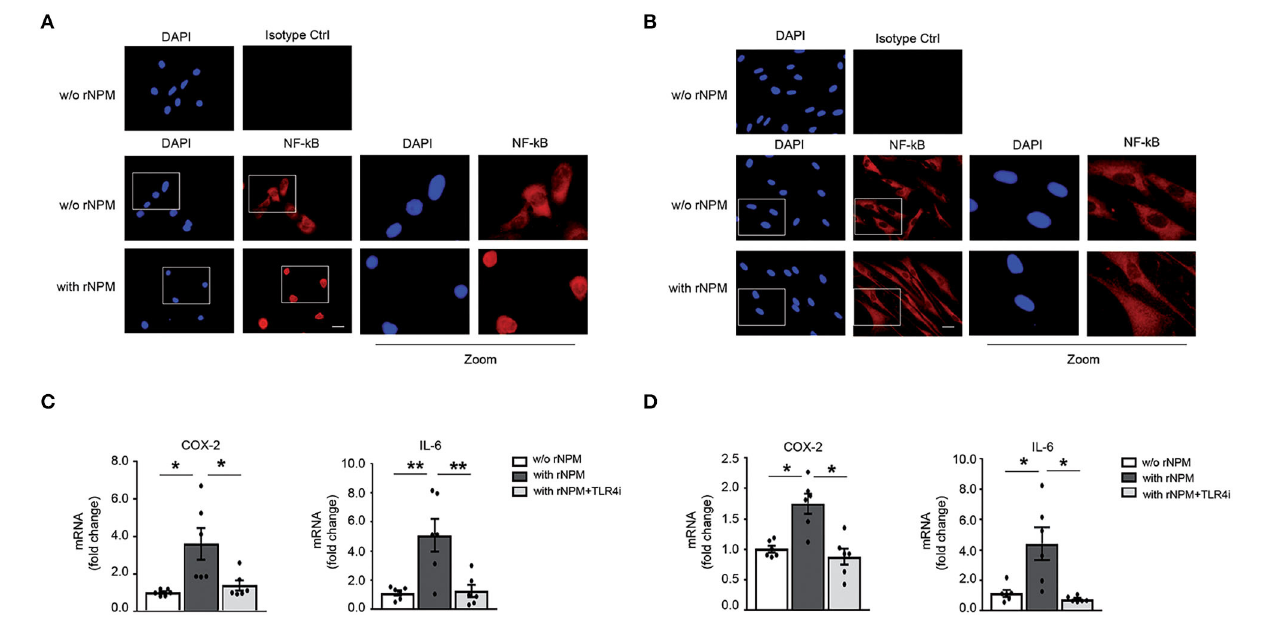
FIGURE 5 | rNPM promotes NF- κ B translocation to the nucleus and induces inflammation in HaCaT and HFs via TLR4. (A) Representative image of immunofluorescence of NF-kB (red) with an α -p65rel NF-kB antibody, nuclei were counter-stained with DAPI (blue). NF κ B translocated in the nucleus in HaCaT treated for 8h with rNPM (0.25 µ g/ml) compared to untreated cells (w/o NPM). Mouse IgG isotype control was used as a negative control. Left panels represent zoomed-in images of the original images. Scale bar 5 µ m. (B) Representative image of immunofluorescence of NF-kB (red) with an α -p65rel NF-kB antibody, nuclei were counter-stained with DAPI (blue). NF- κ B translocated in the nucleus in HFs treated for 8h with rNPM (0.25 µ g/ml) compared to untreated cells (w/o NPM). Mouse IgG isotype control was used as a negative control. Left panels represent zoomed-in images of the original images. Scale bar 5 µ m. (C) HaCaT were pre-treated with 100 µ M TLR4i for 30min and then treated or not for 8h with rNPM (0.25 µ g/ml) compared to untreated cells (w/o NPM). qRT-PCR of COX-2 and IL-6 was significantly reduced by TLR4i upon rNPM treatment ( n = 6; * p < 0.05; ** p < 0.01). (D) HFs were pre-treated with 100 µ M TLR4i for 30min and then treated or not for 8h with rNPM (0.25 µ g/ml) compared to untreated cells (w/o NPM). qRT-PCR of COX-2 and IL-6 was significantly reduced by TLR4i upon rNPM treatment ( n = 6; * p <